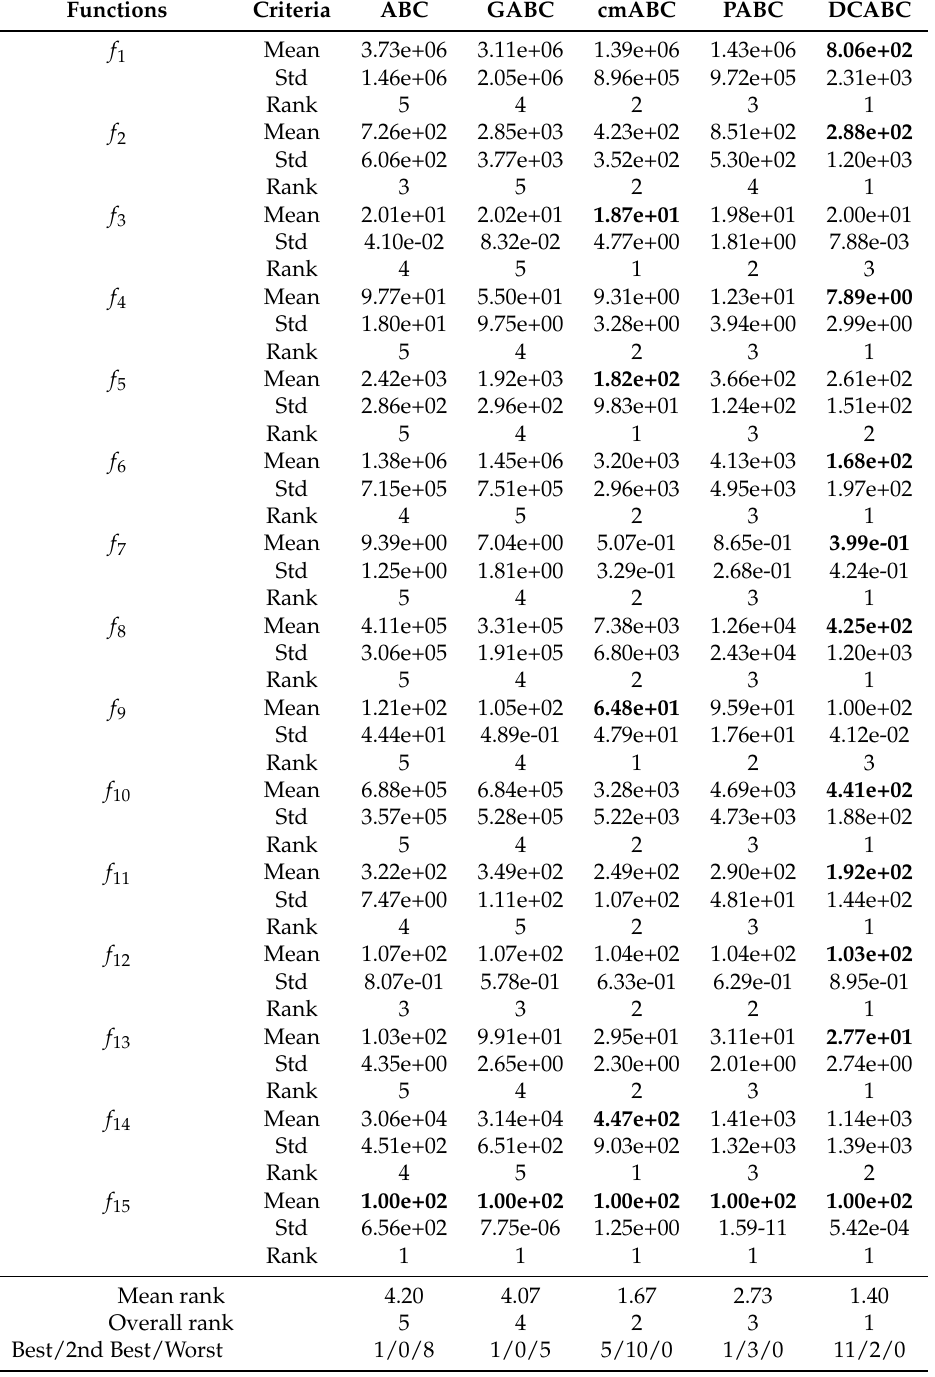
Table 3. Experimental Results about ABC and other ABC variants